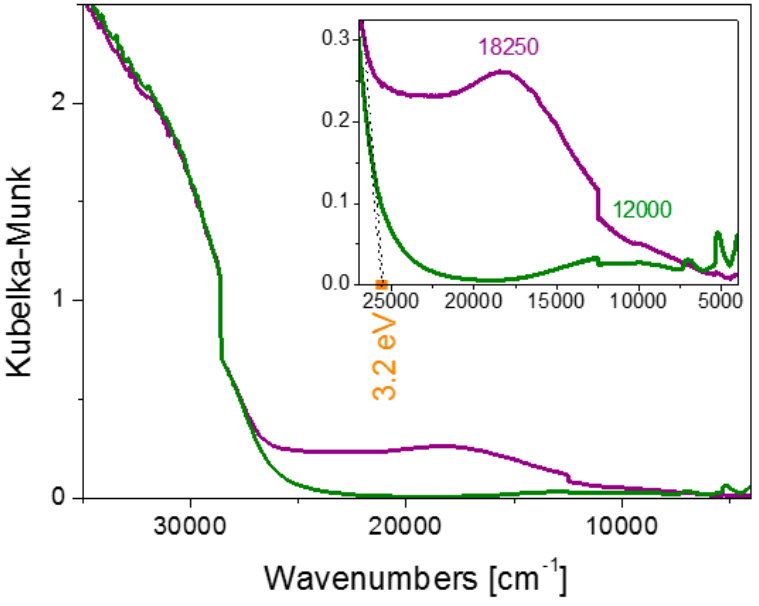
Figure 7. Diffuse reflectance UV ‐ Vis ‐ NIR spectra of the CuO ‐ TiO 2 (green curve) and Au ‐ TiO 2 (violet curve) photocatalysts. Inset: zoom of the spectra in the Vis ‐ NIR region.